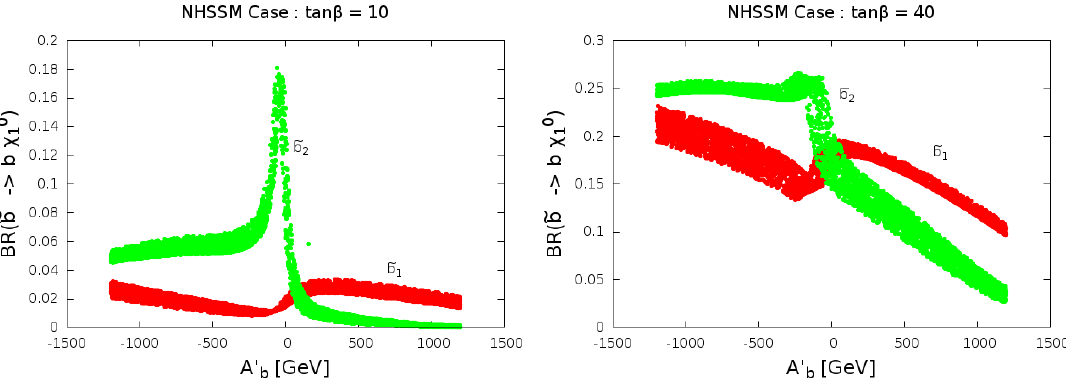
Figure 12 . Branching fractions of ~ b 1 (~ b 2 ) to b(cid:31) 0 The left (right) panel stands for tan (cid:12) = 10 (40). Other (cid:12)xed parameters are: M 1 = 500 GeV, M 2 = 1 : 1 TeV, A t = 2 TeV, A b = 0, m ~ In (cid:12)gure 13 we show the variations of the parton-level yields (i.e., the cross section times the square of BR[~ b ~ b (in green) pair-productions for tan (cid:12) = 10 (40) in the left (right) plot. For the plot on 2